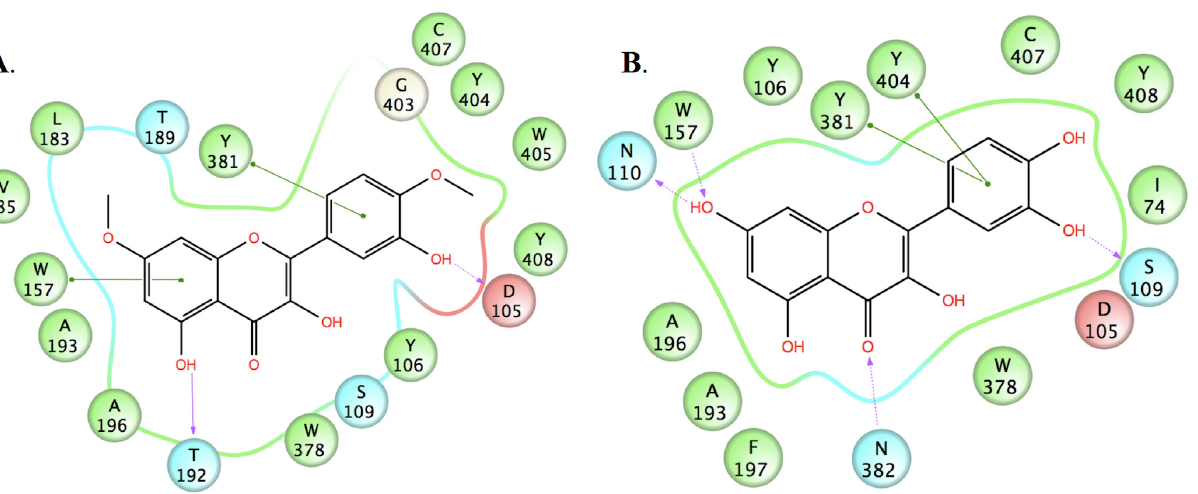
Figure 4. 2D representations of the ligand-receptor interactions of ( A ) ombuin ( 9 ) and ( B ) quercetin ( 12 ) in complex with the human M mAChR model obtained from 1 induced-fit docking using Glide v5.7 and Prime v3.0 (Schrödinger LLC), showing pi-pi stacking interactions (green lines), hydrogen bonds involving backbone atoms (solid purple arrows) and hydrogen bonds involving side-chain atoms (dashed purple arrows). Negatively-charged, polar and hydrophobic residues are depicted with red, light blue and green circles,